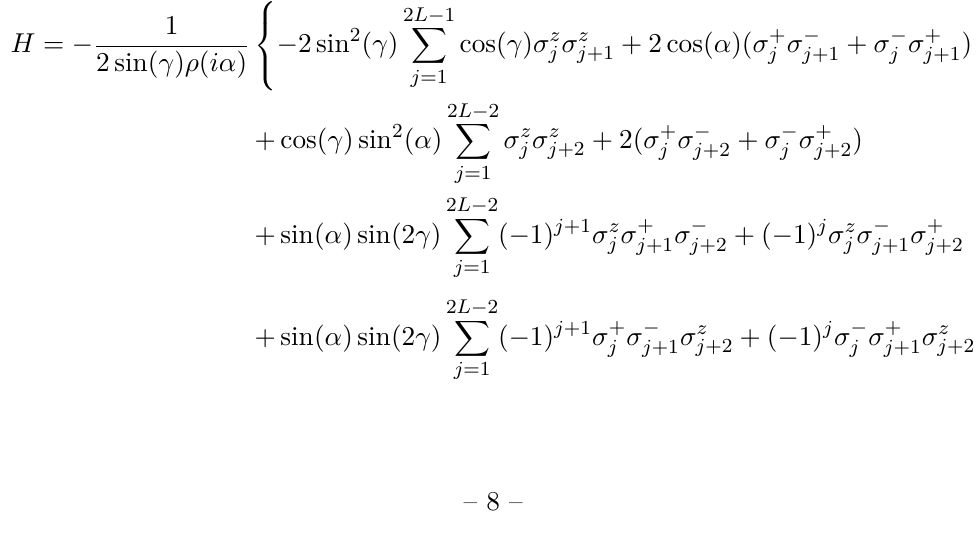
(cid:0) (cid:1) (cid:0) (cid:1) u − iα /τ u + iα evaluated at 2 2